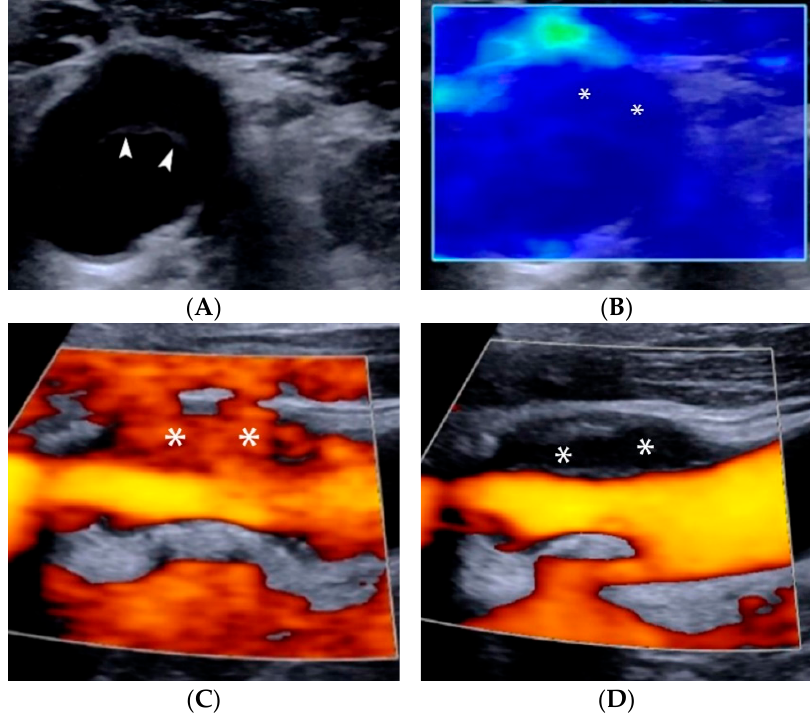
Figure 4. Ultrasonographic assessment of plaque stiffness. B-mode axial image ( A ) showing a hypoechoic plaque causing positive remodeling. Note a thin echogenic layer representing the plaque’s fibrous cap (arrowheads). Shear-wave elastography ( B ) showing low shear-wave velocity values and thus lower stiffness in the plaque’s core (dark blue colour, asterisks) but a slightly higher value and stiffness for the fibrous cap (slightly brighter blue layer covering the core on the luminal aspect of the plaque). The Power Doppler vocal fremitus artifact could be appreciated with the soft plaque covered by signals when the patient spoke ( C , asterisks). A smooth surface of the plaque (asterisks) was appreciated when the patient was still ( D ).